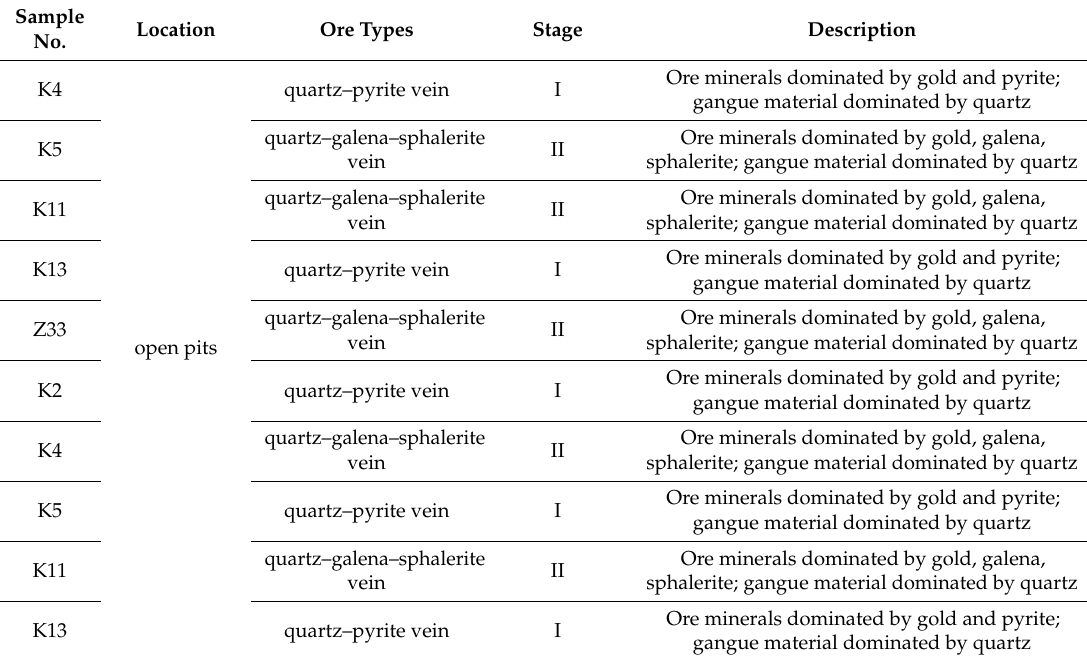
Table 2. Location and description of S–Pb isotope samples from the Xiajinbao Au deposit. Sample